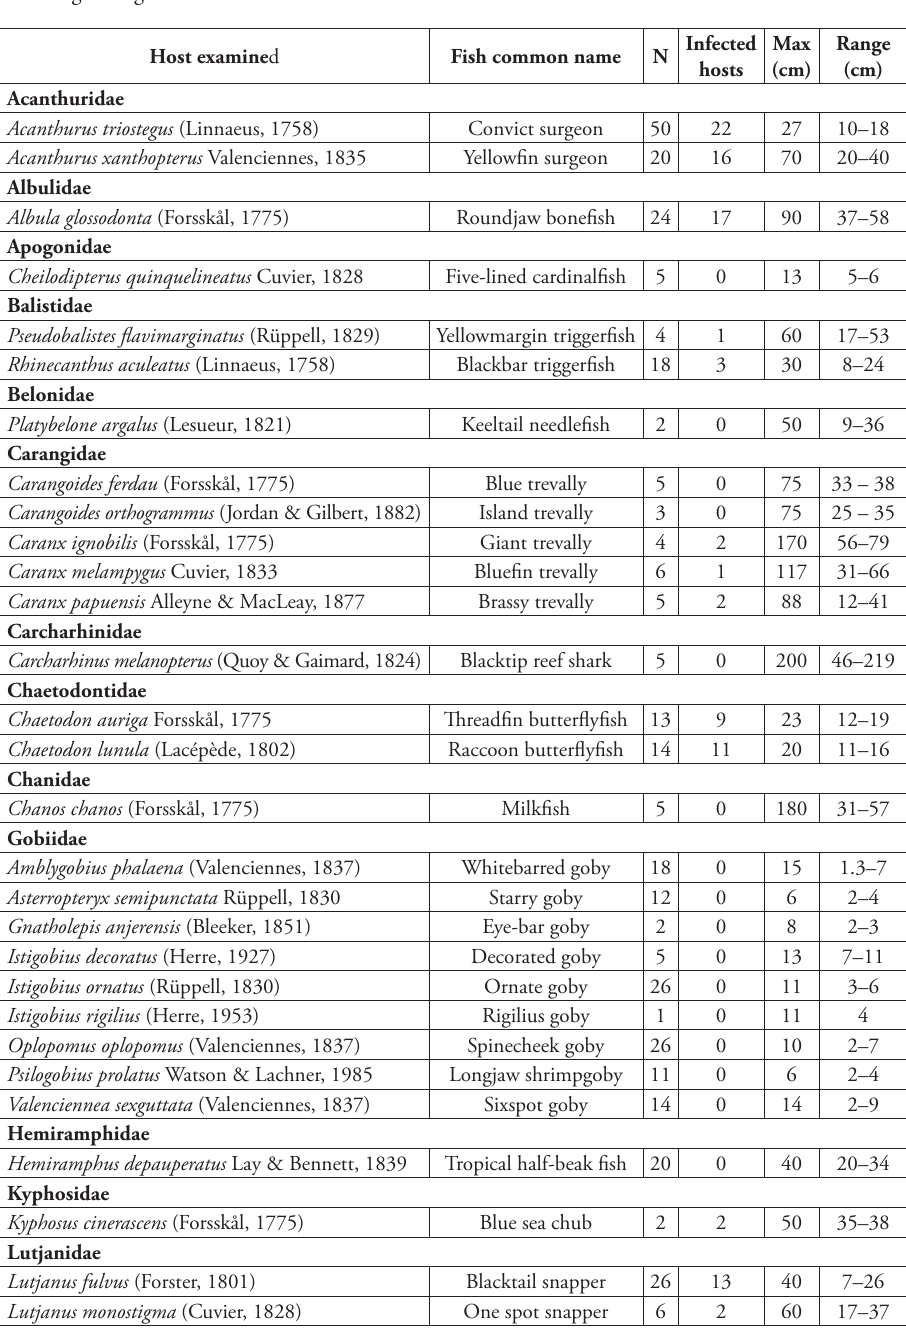
Table 1. Fish species examined from the lagoon flats of Palmyra Atoll. N = number of fish examined; Max = maximum length reported for that fish species in FishBase ( http://www.fishbase.se ); Range = total length range of the fish